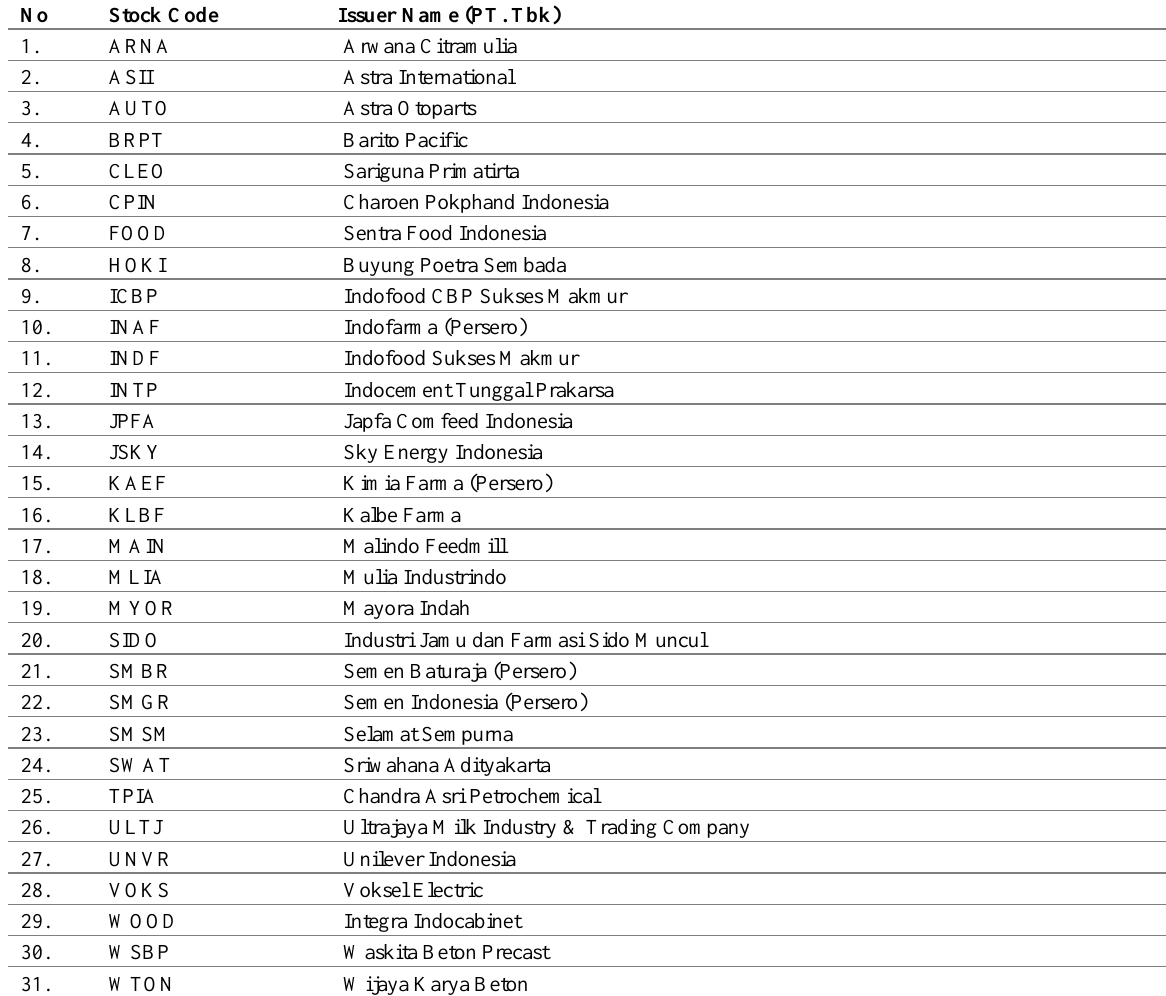
Table 1: List of Manufacturing Entities used as Research Samples January 2019-January